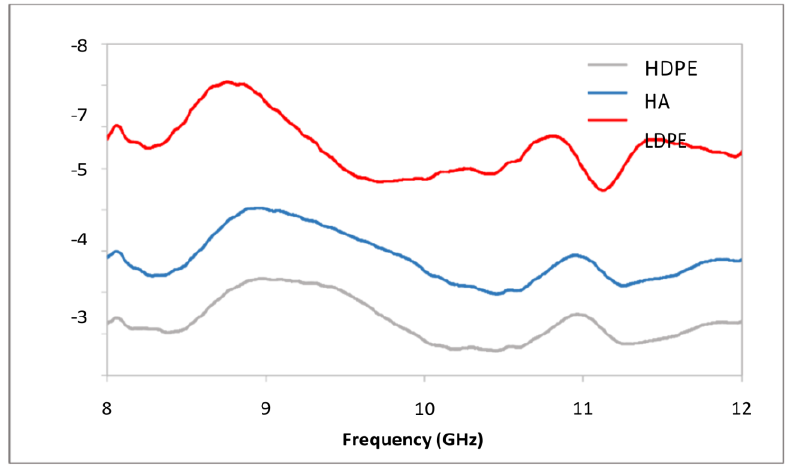
Figure 11. Total EMSE of PCF/PE composites in X band.